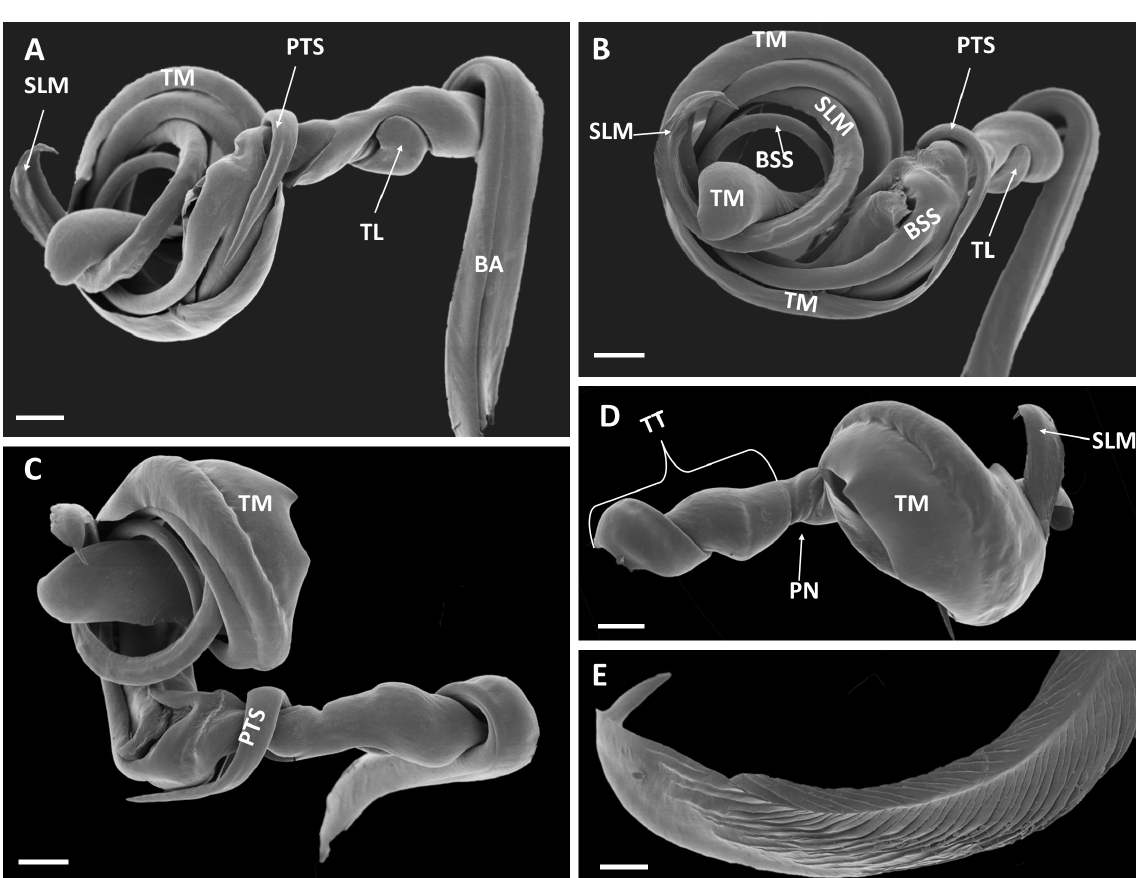
Fig. 11. Aptyctosmilax helenae gen. et sp. nov., holotype, ♂ (NHMD 621701), left gonopod telopodite. A . Posterior view. B . Posterio-mesal view. C . Ventral view. D . Anterior view, without basomere. E . Tip of solenomere. Abbreviations: BA = basomere; BSS = basal solenomeral spine; PN = post-torsal narrowing; PTS = post-torsal spine; SLM = solenomere; TL = torsotope lobe; TM = telomere; TT = torsotope. Scale bars: A–D = 0.2 mm; E = 0.05